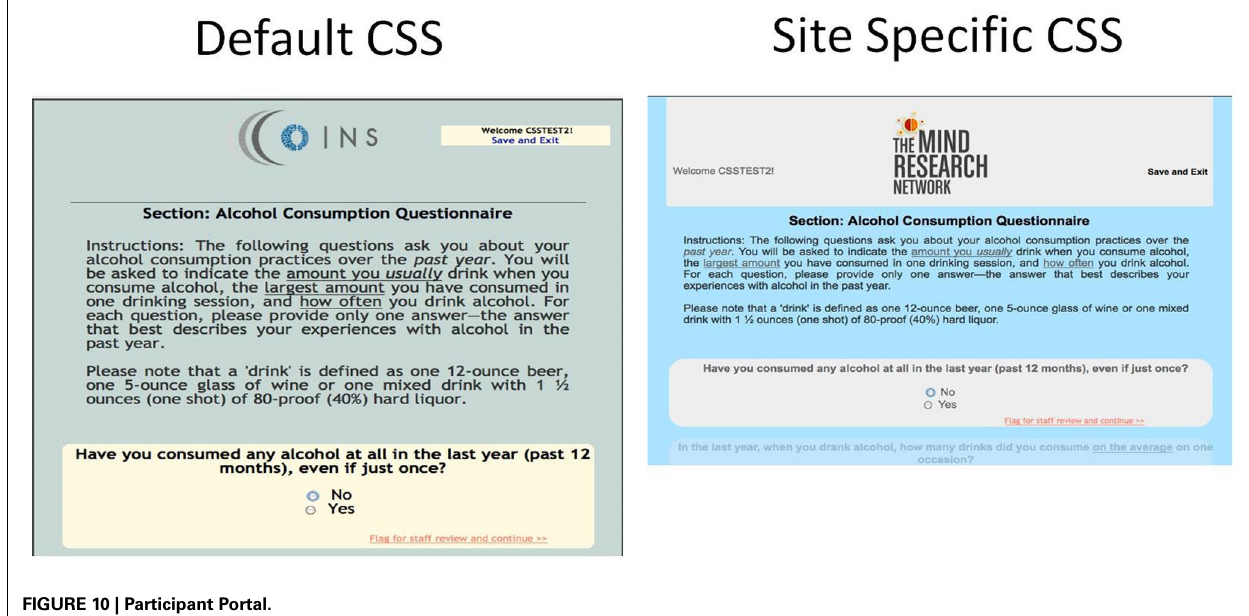
FIGURE 10 | Participant Portal.